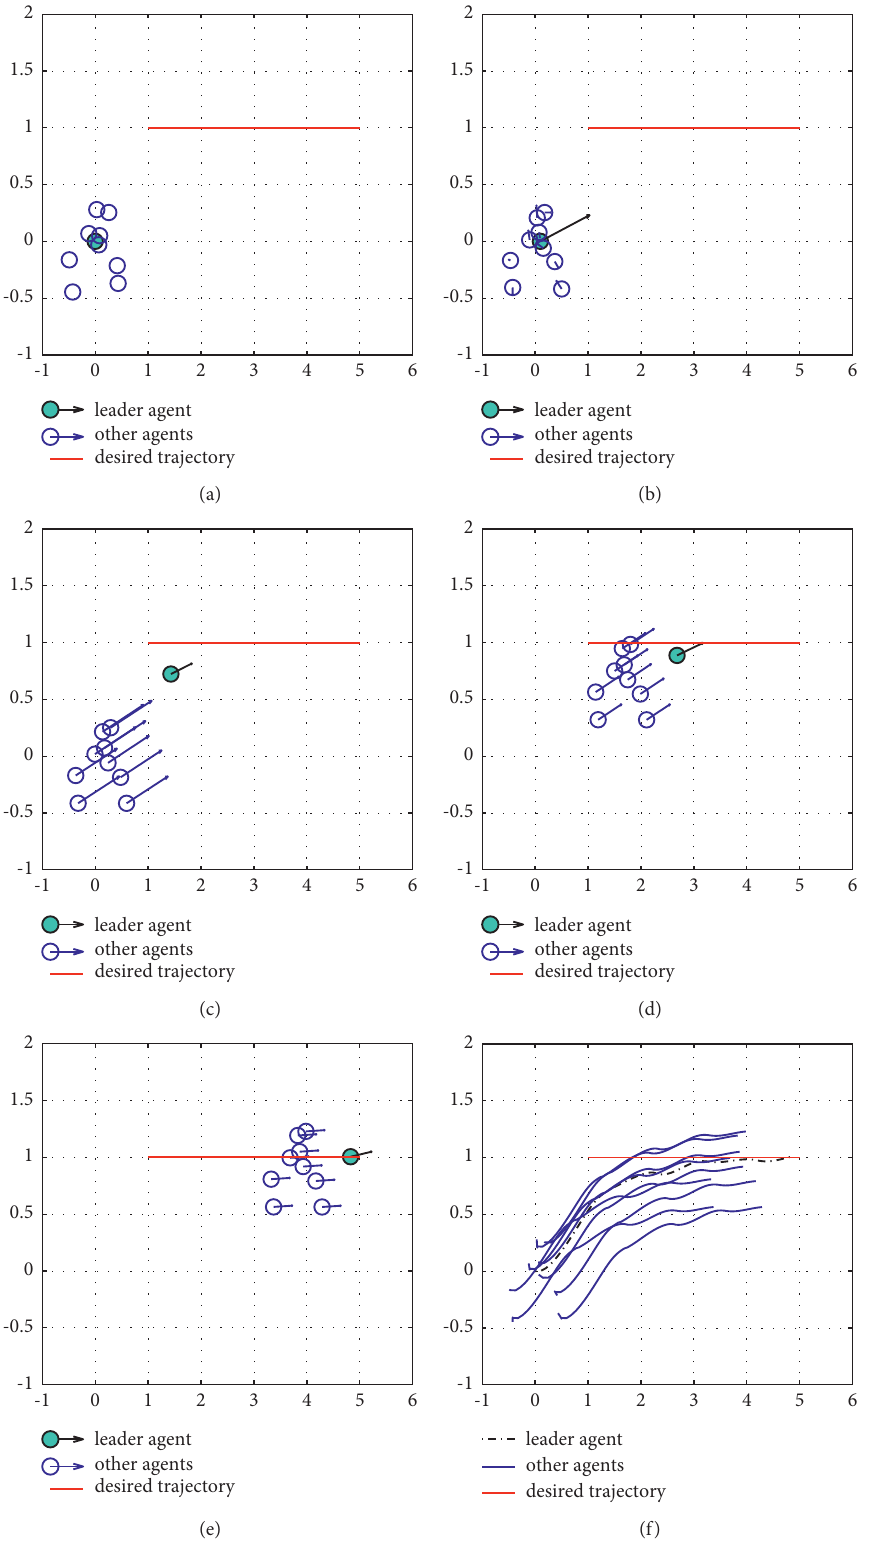
Figure 5: The movement of agents following desired linear path. Time delay is given by τ � 2 for t ∈ [ 0 , 10 ] . (a) Initial configuration. (b) t � 1. (c) t � 2. (d) t � 5. (e) t � 10. (f) t ∈ [ 0 , 10 ]